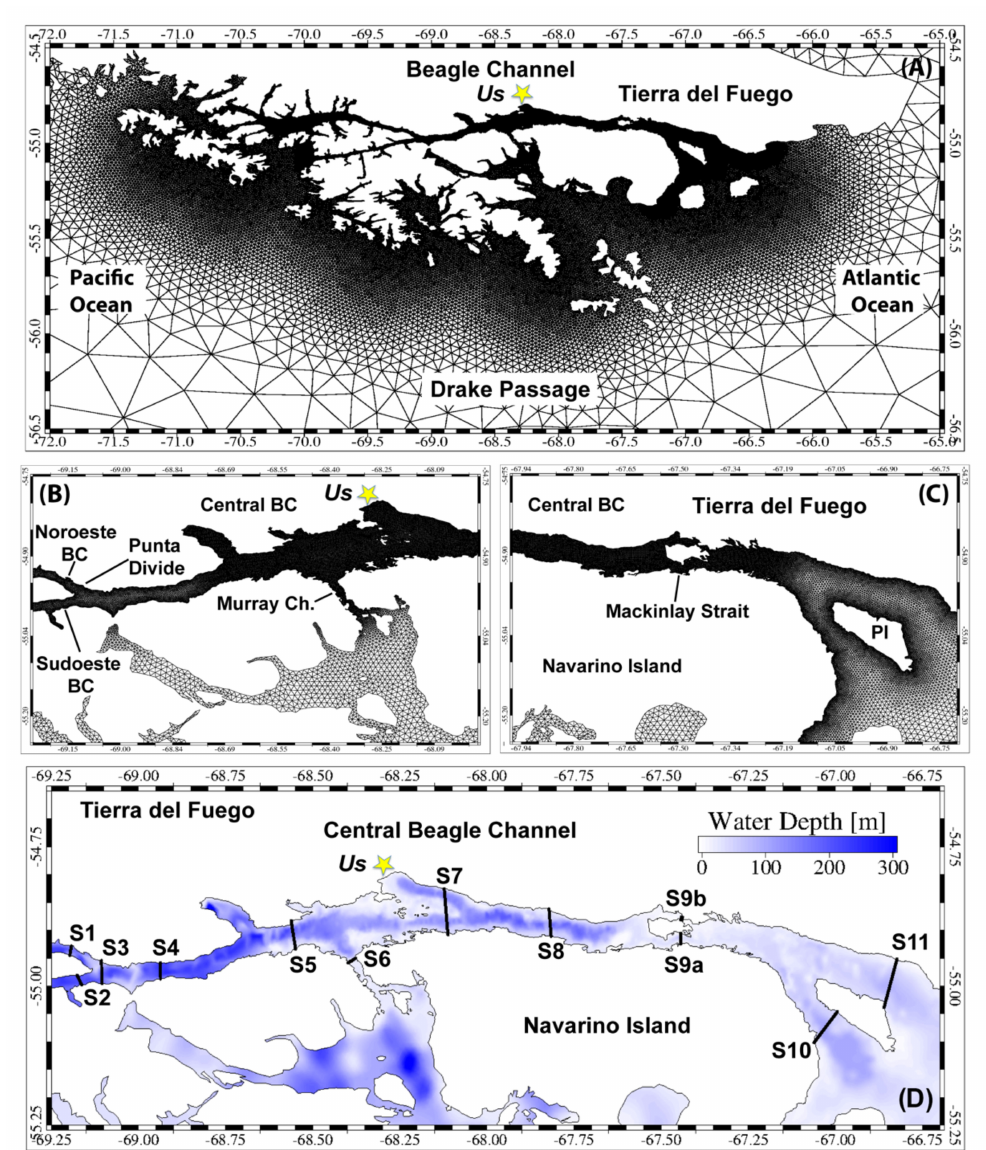
Figure 2. Zoom areas of the finite element mesh for the BC ( A – C ). Bathymetric details of the central part of the BC as reproduced by the model mesh ( D ). S1 to S11 indicate the sections through which the water fluxes were computed during the simulation run. The label “Us” indicates the location of the city of Ushuaia and the bay of the same